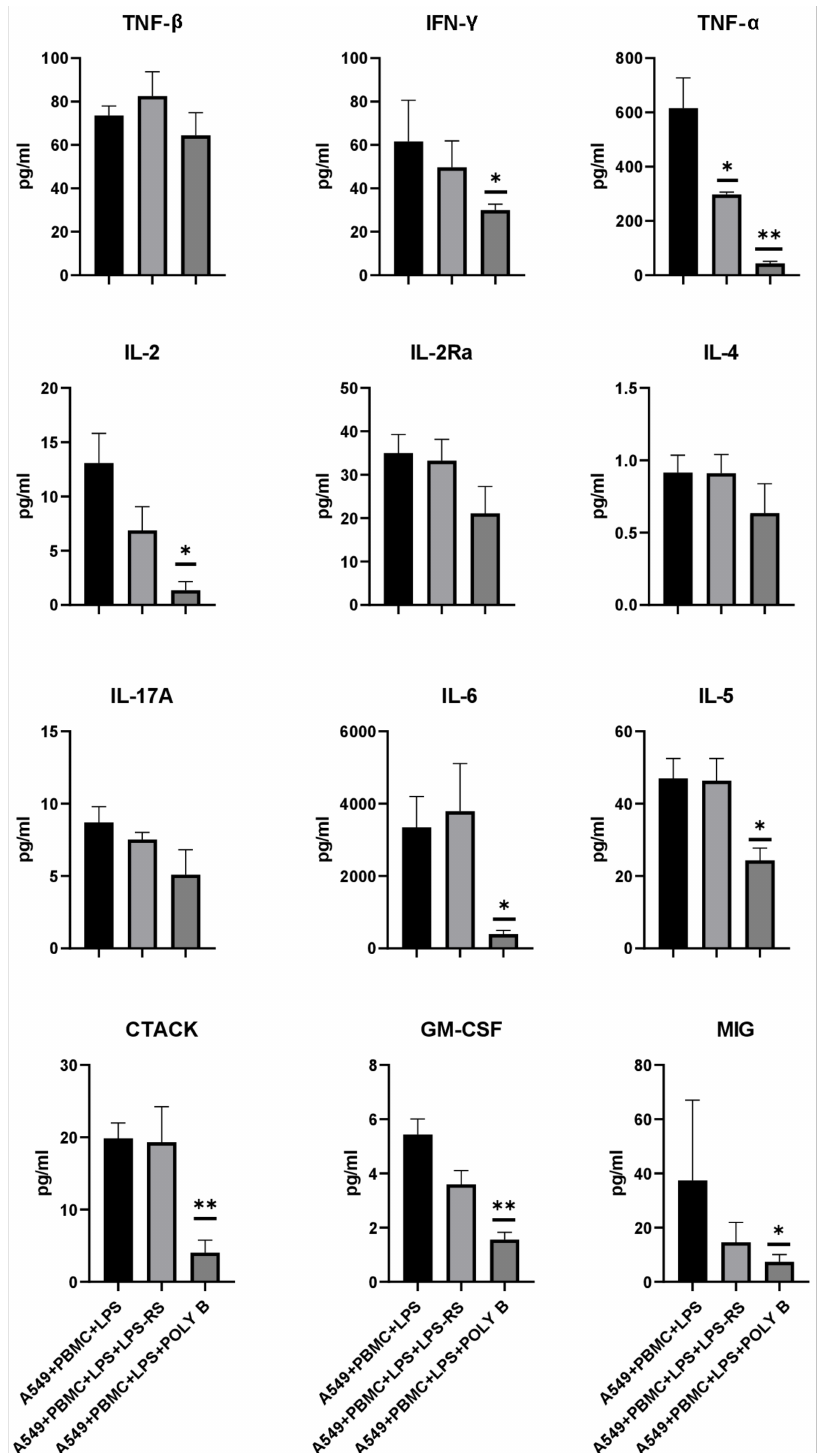
Figure 8. Influence of LPS-RS and polymyxin B on cytokine/chemokine concentrations in conditioned medium from the model system after 24 h treatment. Data are presented as a mean ± SEM, n = 3. * p < 0.05, ** p < 0.01; significance from the A549 + PBMC + LPS is assessed by one-way ANOVA with Tukey’s multiple comparisons